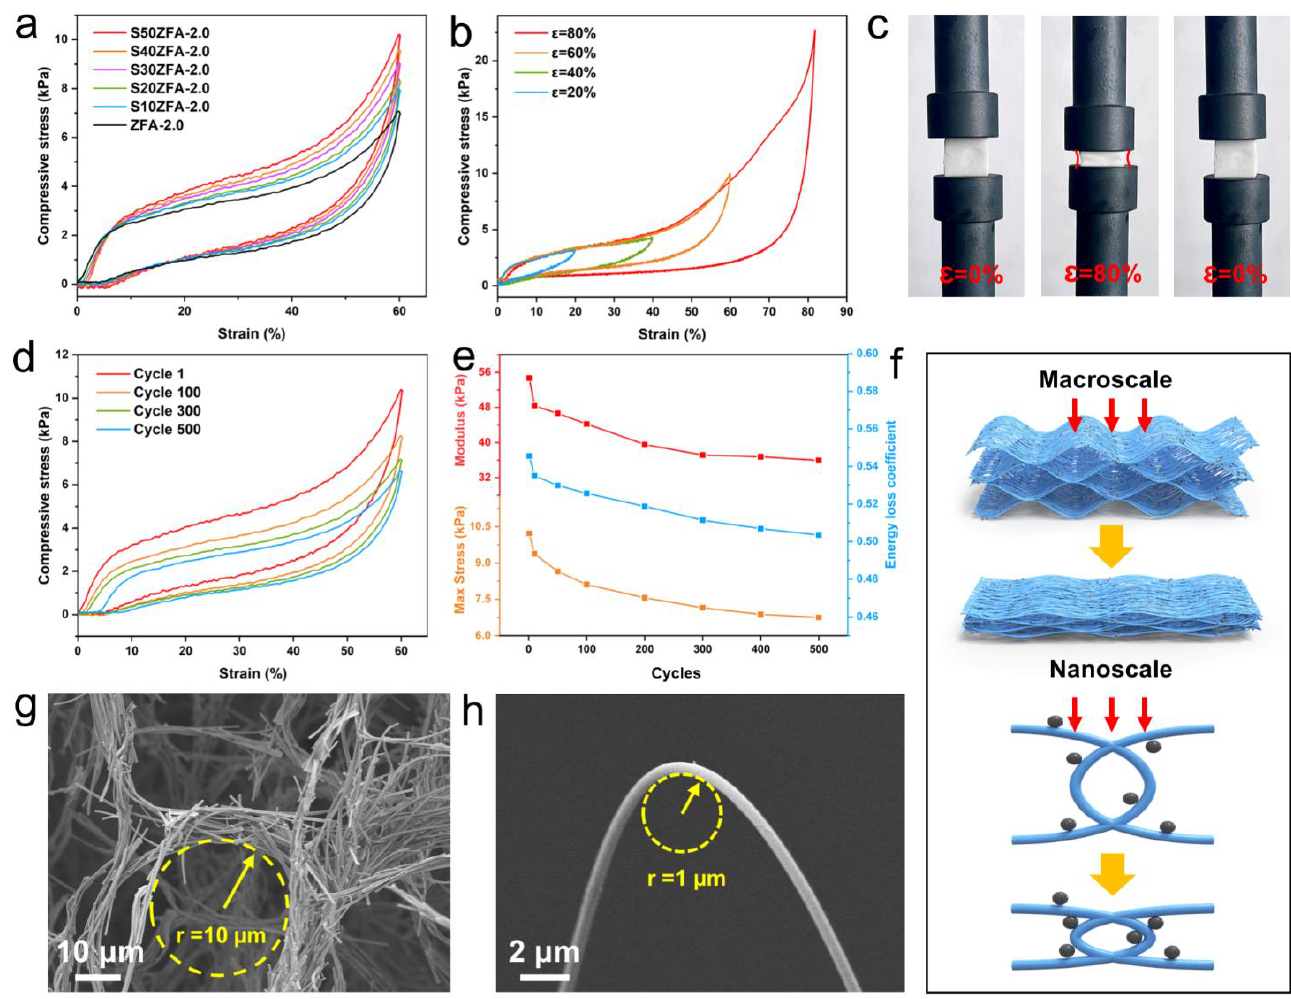
Figure 5. ( a ) Stress–strain curves (60% strain) for ZFA-2.0 and SZFAs with different SiC contents. ( b ) Stress–strain curves of S50ZFA-2.0 at different strains. ( c ) Photograph of the compression process of S50ZFA-2.0 (80% strain). ( d ) Compression cycle curves of S50ZFA-2.0 (60% strain, 500 cycles). ( e ) Curves of elastic modulus, maximum stress, and energy loss coefficient with increasing compression cycles. ( f ) Schematic of the elastic deformation mechanism. Curvature radius of ( g ) a single honeycomb structure and ( h ) a single fiber.